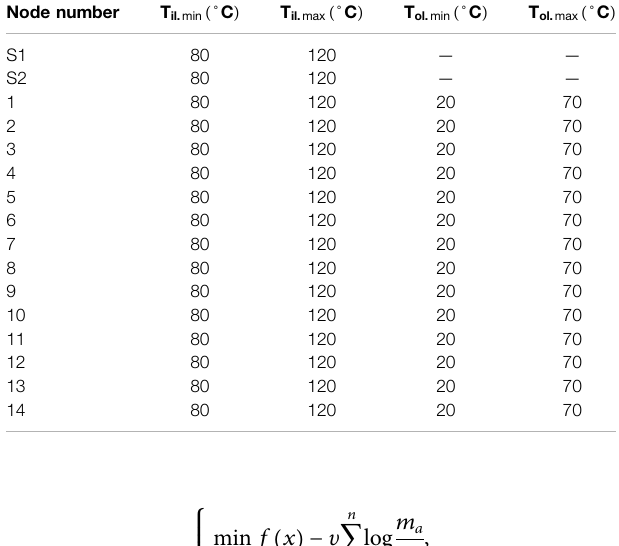
FIGURE 4 | Comparison of power fl ow calculation results.